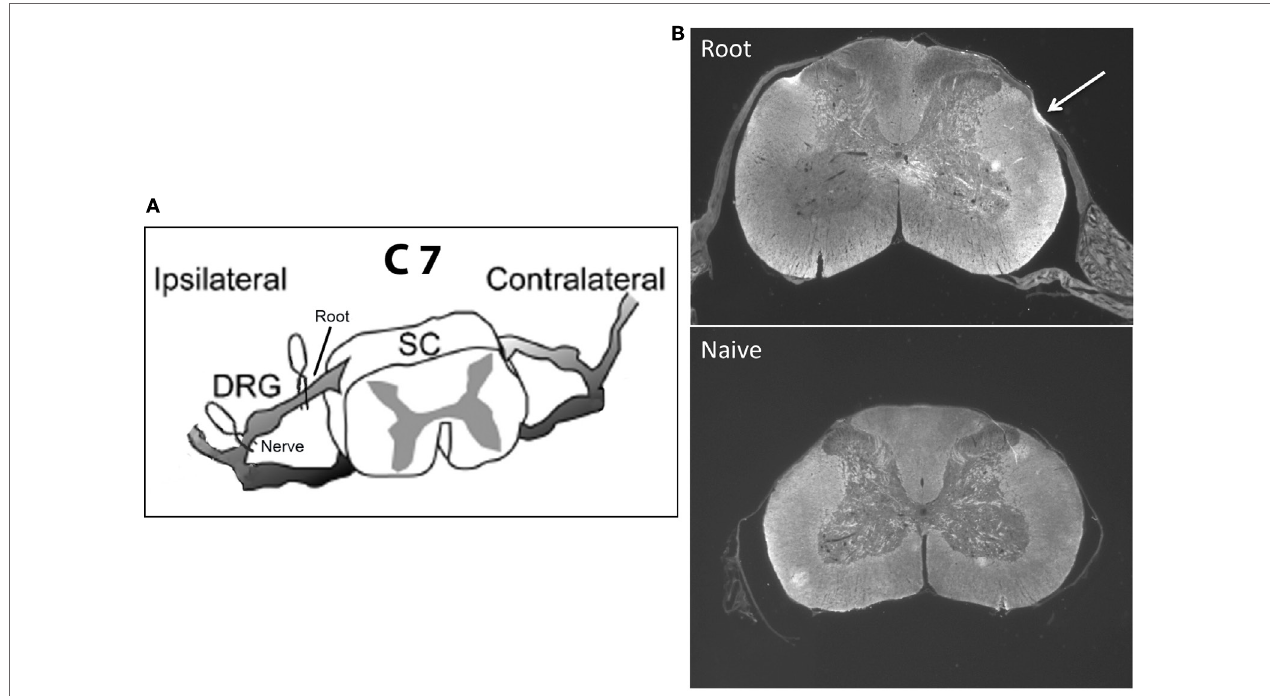
FigUre 1 | (a) shows a schematic of the location of the microclips distal (nerve compression) and proximal (root compression) to the DRG. The nerve root compression was applied to the dorsal root as it exited the DRG. The nerve compression was of the mixed nerve just prior to its entering the DRG. (b) is a sample photomicrograph of myelin basic protein staining 14 days following root compression in a 28-day old animal (top) and a same age control (bottom). The arrow denotes the site of compression. We use these figures only to show the nature of the compression injury and not to imply any quantitative